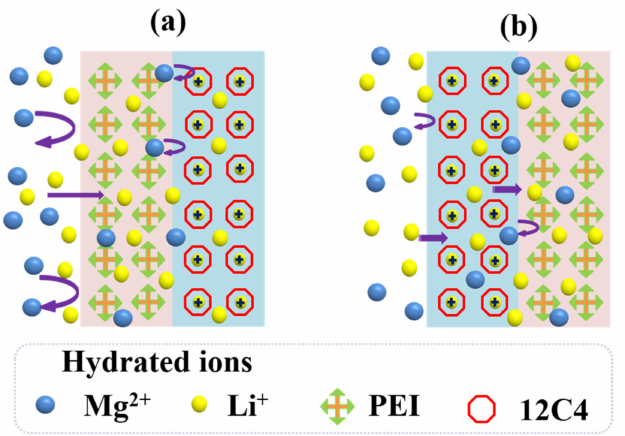
Figure 11. Analysis for the selective permeation of cations (Li + and Mg 2+ ) through modified layers of membranes ( a ) M-12C4-0.50-PEI and ( b )